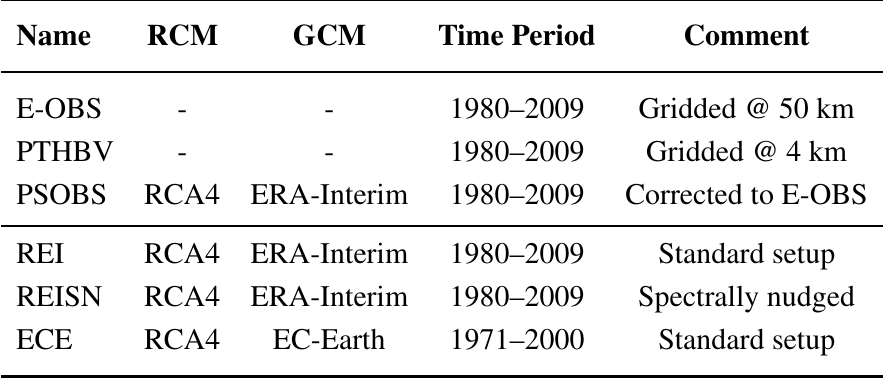
Table 1. List of model simulations, observational and merged data. The indicated time period is that used for the analysis, not that of the complete data